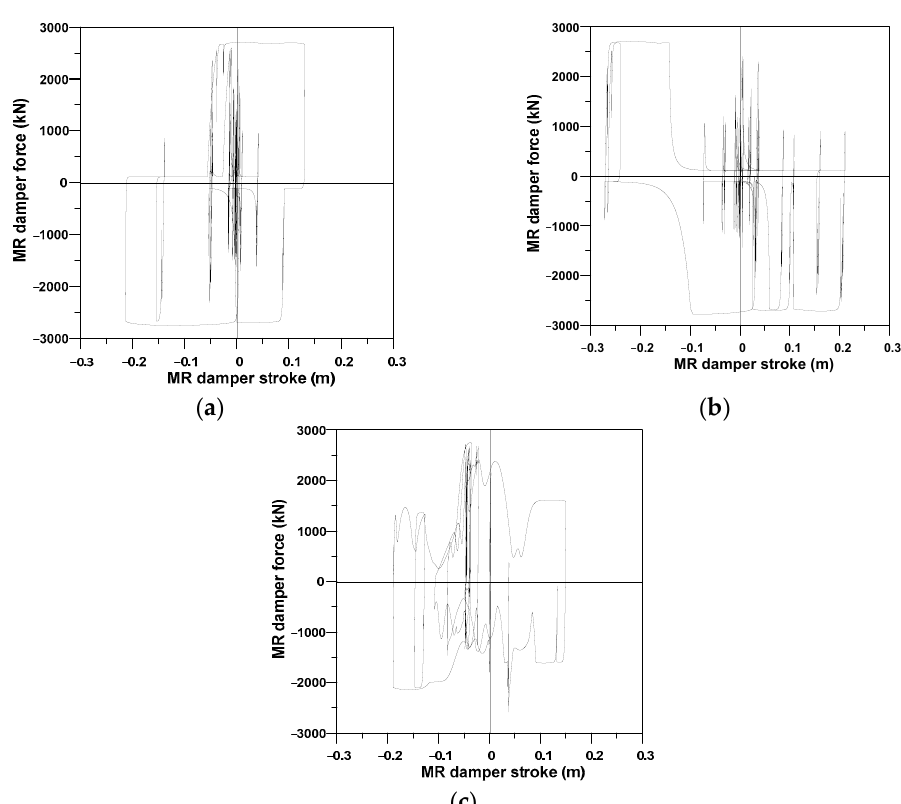
Figure 19. MR damper stroke-and-force relationship (EV1): ( a ) groundhook algorithm, ( b ) skyhook algorithm, ( c ) DQN algorithm.